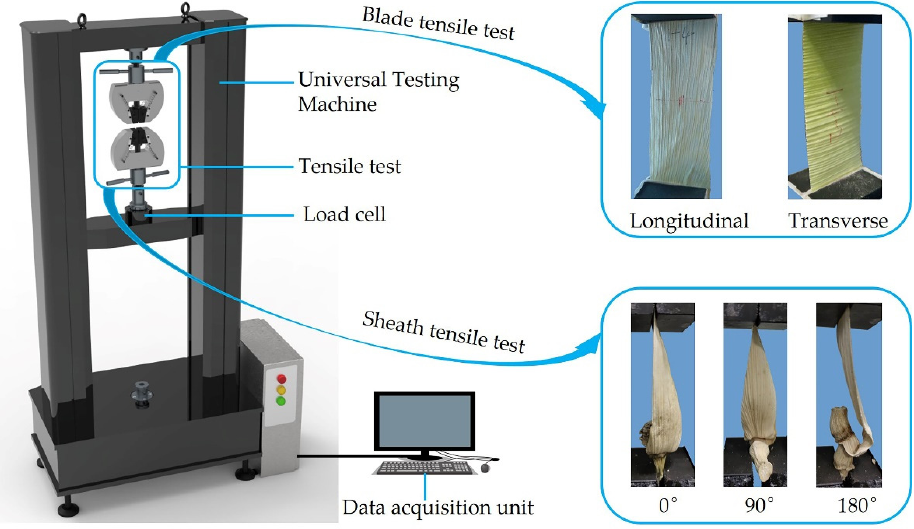
Figure 3. Setup for tensile test.